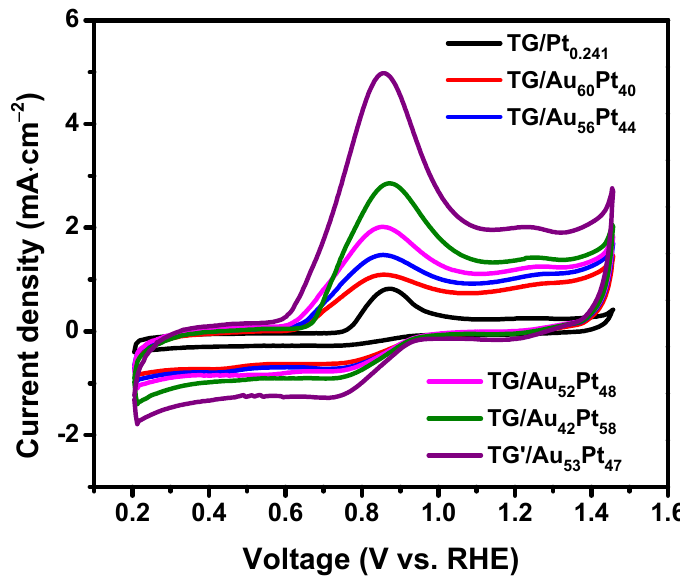
Figure 8. CO-stripping curves on TG-based catalysts in 0.5 M KOH. Table 3. Comparison of catalyst performance of various graphene-based catalysts. GO: graphene oxide; TG: tubular graphene; NPs: nanoparticles; NA: nanoalloy. Catalyst